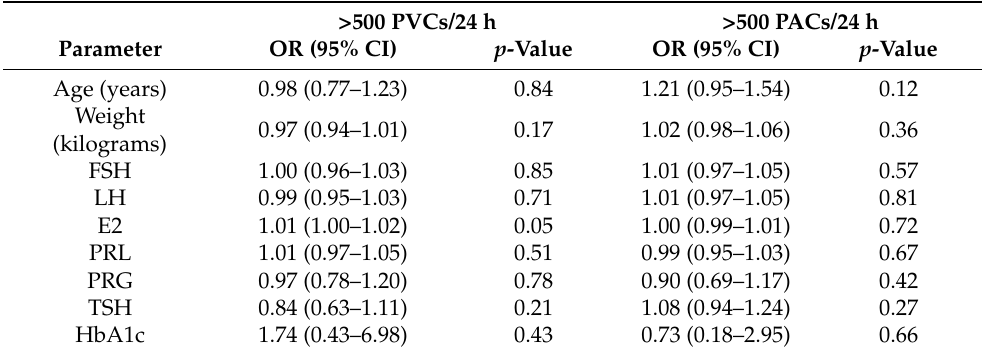
Table 2. Odds ratios and 95% confidence intervals estimated by univariate logistic regression for the appearance of >500 PVCs/24 h and >500 PACS/24